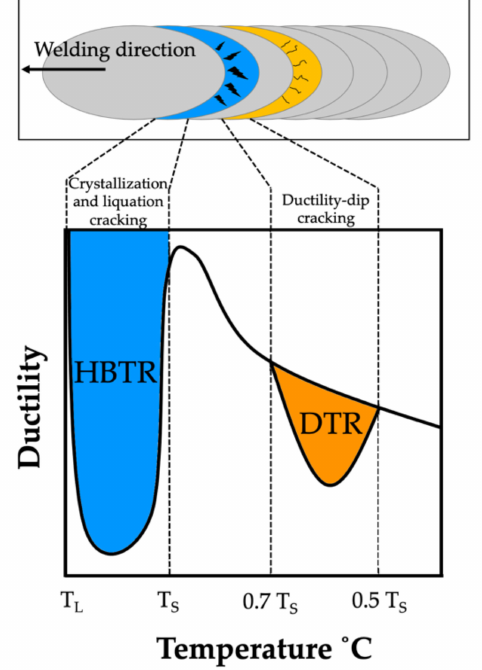
Figure 1. Areas of hot-crack initiation in the weld and the heat affected zone.